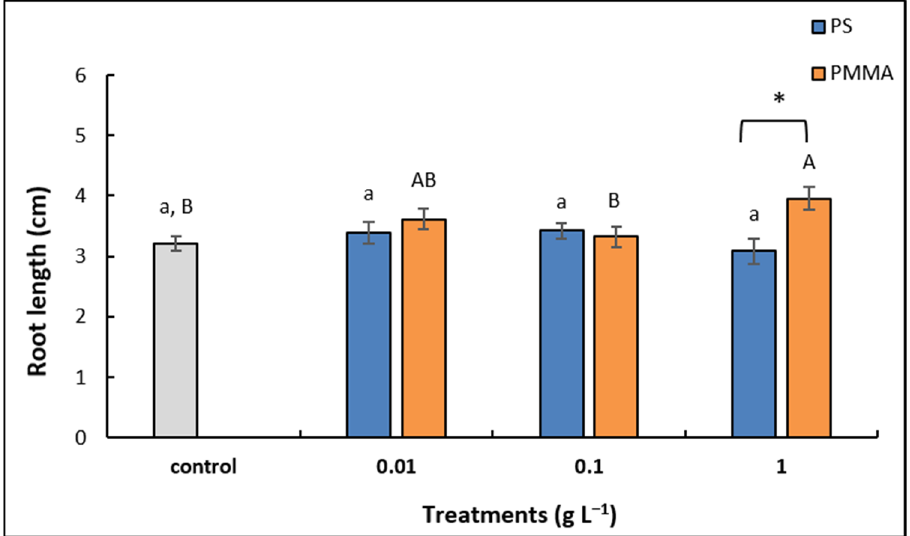
Figure 2. Length of A. cepa control roots and after 72 h treatment with 0.01, 0.1, and 1 g L − 1 of PS-MPs and PMMA-MPs. Values are means ± standard errors of two different experiments, each with 6 replicas ( n = 12). If columns are marked with different letters or asterisk, the treatments are significantly different at p ≤ 0.05 (one-way ANOVA followed by Duncan post hoc test); small letters mark the differences among different concentrations of PS-MPs and control, capital letters mark the differences among different concentrations of PMMA-MPs and control, and asterisk (*) denotes difference between the same concentration of different MP